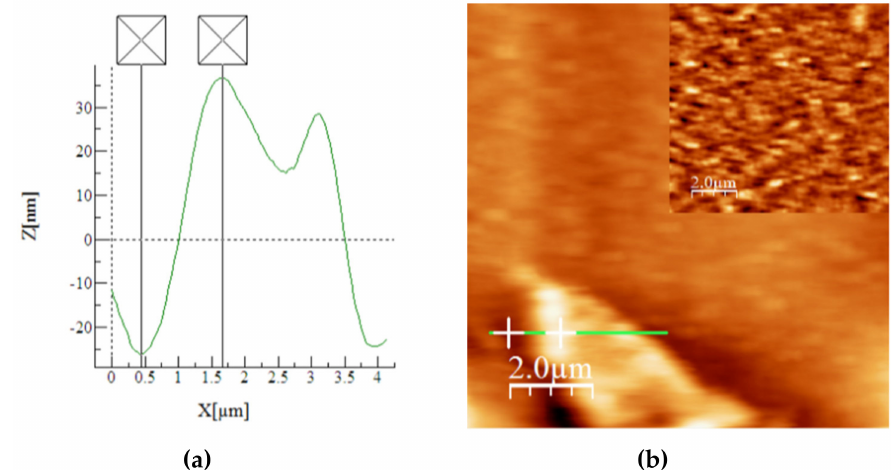
Figure 8. The height of the RGO sheet on the Au electrode ( a ) and atomic force microscopy (AFM) images of the blank Au electrode (insert in b) and Au electrode covered with the RGO sheets ( b ). According to Figure 9, the main Raman lines of P5A1N electrosynthesized onto the Au electrode have peaks at 738–846–939, 1193, 1276, 1322–1338, 1428, 1579 and 1620 cm –1 , these being